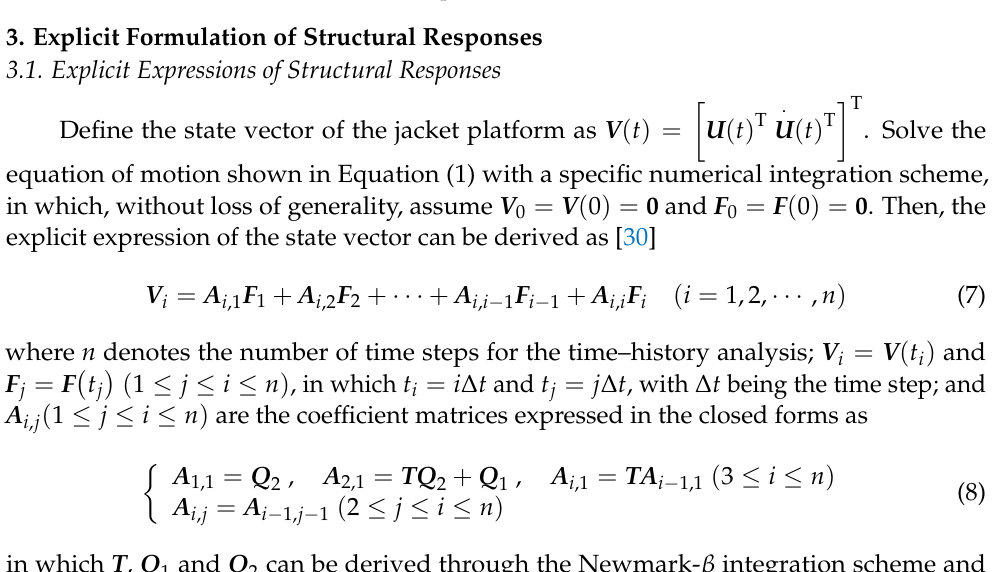
Figure 1. Distributed wave loads and fluid–particle velocities and accelerations.